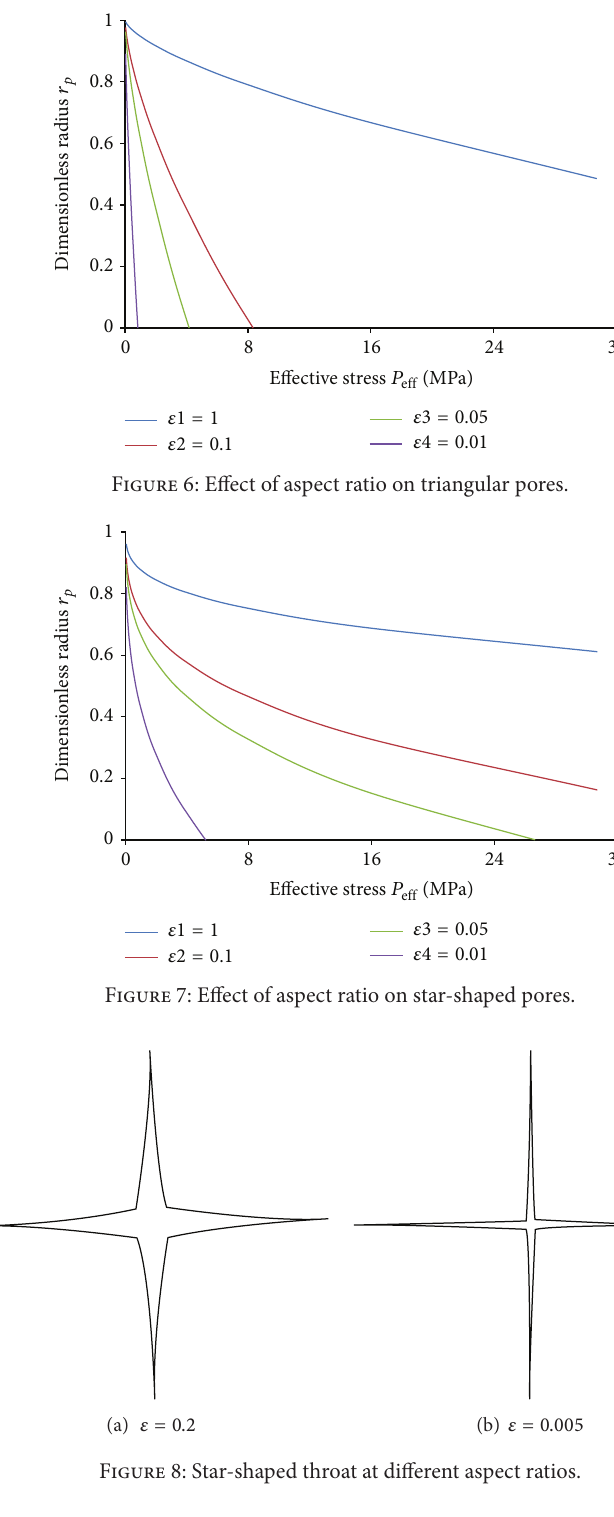
sionless radius and the effective stress can be explained through different pore shape combinations based on the network